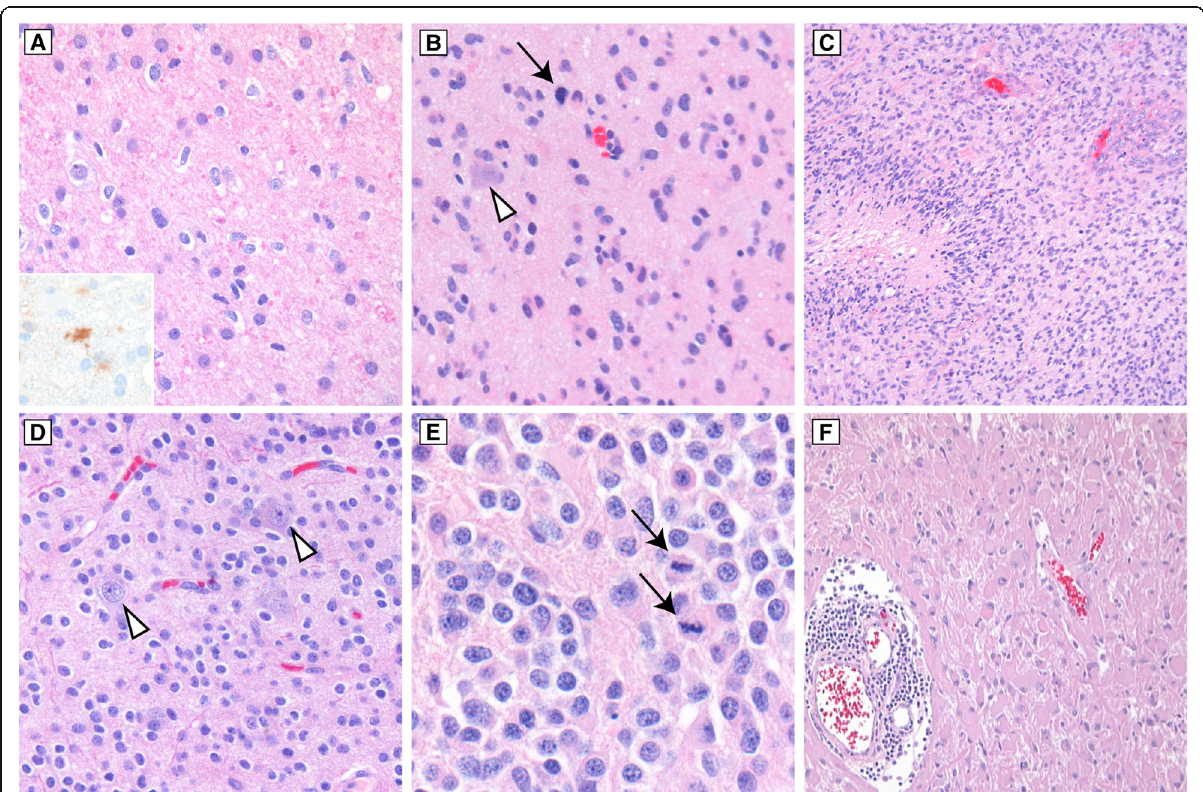
Fig. 2 Typical histologic features of infiltrating gliomas. In diffuse astrocytomas ( a ), cellularity is increased due to infiltrating neoplastic astrocytes with irregular, hyperchromatic nuclei and scant associated cytoplasm. Immunohistochemistry for IDH1 R132H mutant protein (A, inset) can be helpful when infiltrating cells are sparse or rare. b Anaplastic astrocytoma is distinguished by mitotic activity (black arrow). Note the infiltrating tumor cells around a non-neoplastic neuron (white arrowhead). c Palisading necrosis (left) and endothelial proliferation (upper right) are histologic features of glioblastoma, though neither feature is absolutely specific. d WHO grade II oligodendroglioma with uniform, rounded nuclei and perinuclear clearing, the latter feature being an artifact of formalin fixation. Infiltrative growth is demonstrated by entrapped non-neoplastic neurons (white arrowheads). e Oligodendrogliomas with high cellularity, cytologic atypia, significant mitotic activity (black arrows) generally defined as 6 or more mitoses per 10 high-power fields, and vascular proliferation qualify for anaplastic oligodendroglioma, WHO grade III. Necrosis often accompanies vascular proliferation and mitotic activity, but is not required. f Gemistocytic astrocytoma appears as cells with abundant, glassy, eosinophilic cytoplasm, and frequently is associated with perivascular inflammatory infiltrates. This astrocytoma subtype has a propensity toward rapid malignant